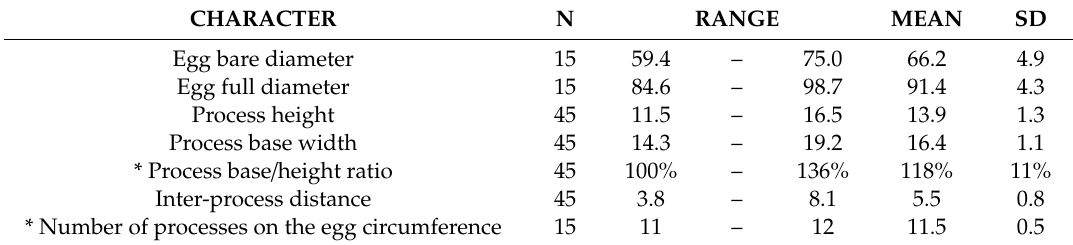
Table 6. Measurements (in µ m) of selected morphological structures of eggs of the Polish (cultured) population of Paramacrobiotus fairbanksi Schill, Förster, Dandekar and Wolf [25] mounted in Hoyer’s medium (N, number of eggs / structures measured; RANGE refers to the smallest and the largest structure among all measured eggs; SD, standard deviation). * except of values of ratio which is presented as percentage and number of processes on the egg circumference which is as number.